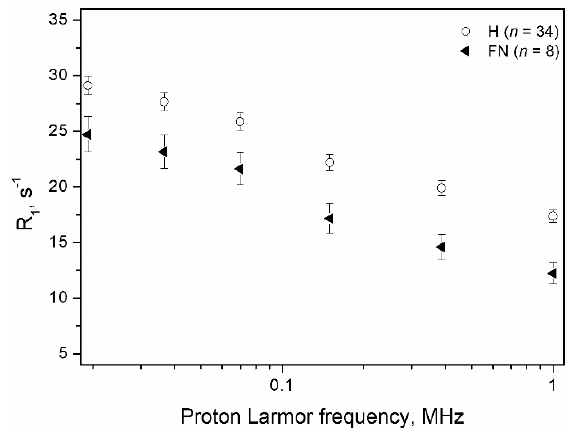
Figure 4. Comparison between the NMRD profile of the H samples with the averaged NMRD profiles of the 8 specimens that, on the basis of the applied Ratio criterion, resulted to be FN samples (n = 8). Error bars represent the standard errors.